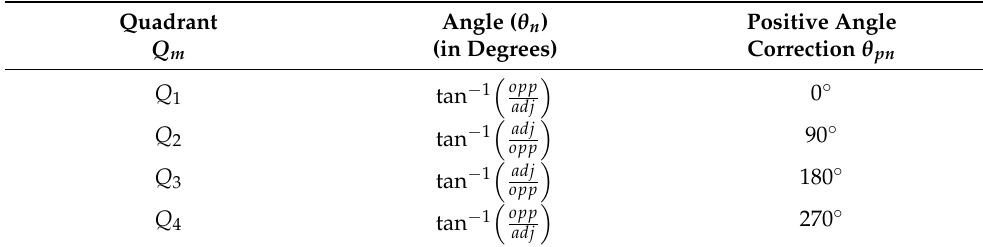
Table 4. Angle calculations.